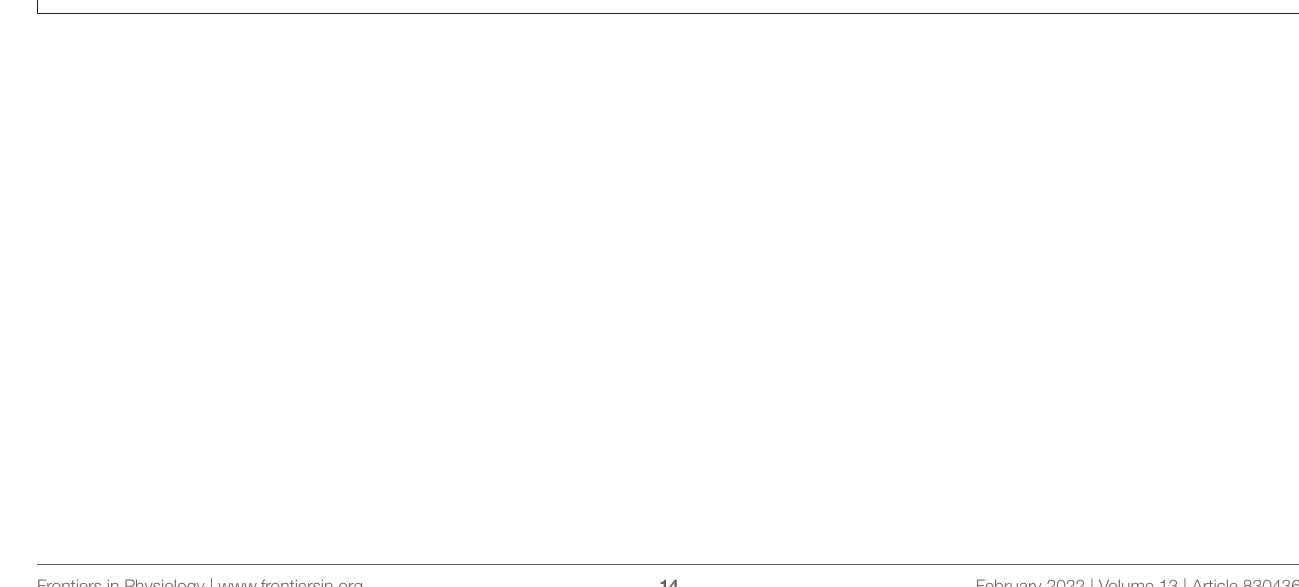
Frontiers in Physiology |